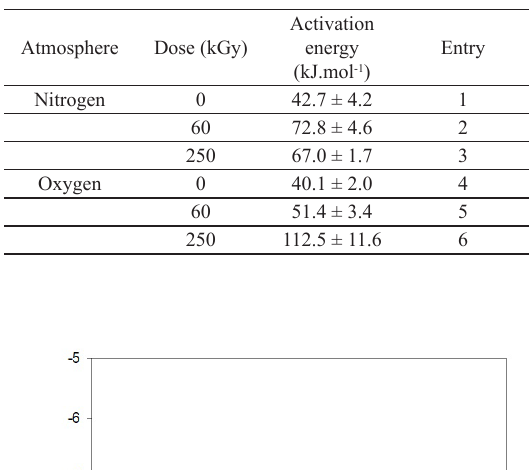
Table 4. Average activation energy, E Starink method 27 at heating rates of 10, 30 and 50 °C.min -1 , at conversion fraction x of 0.2 – 0.8.